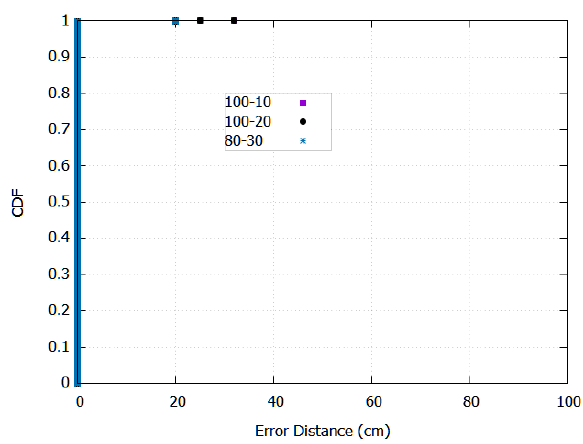
Figure 10. CDF for 100-10, 100-20 and 80-30 nodes.